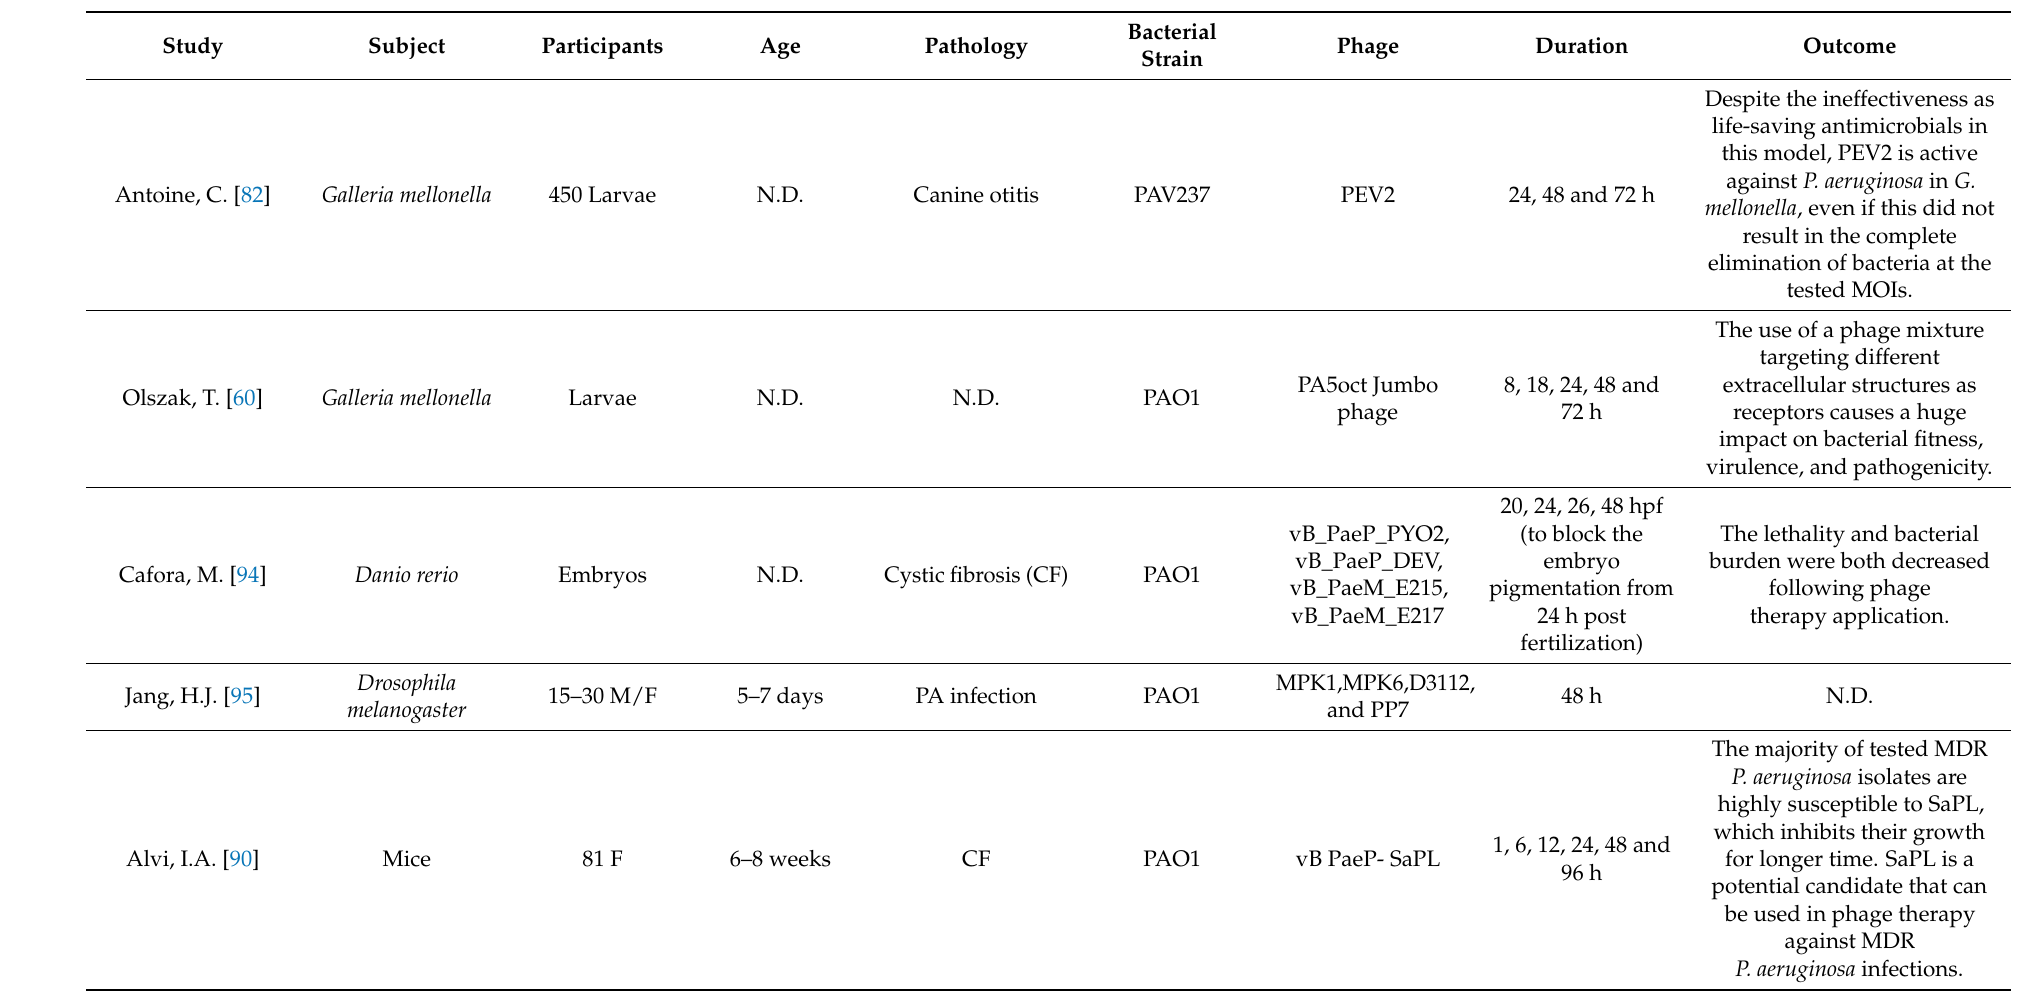
Table 4. In vivo studies about phage therapy for Pseudomonas aeruginosa